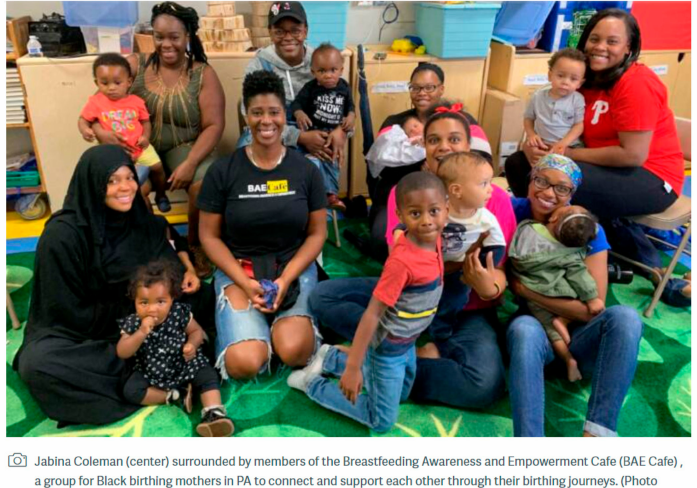
Figure 2. BAE Cafe feature from WHYY Philadelphia about decreasing racial gaps in